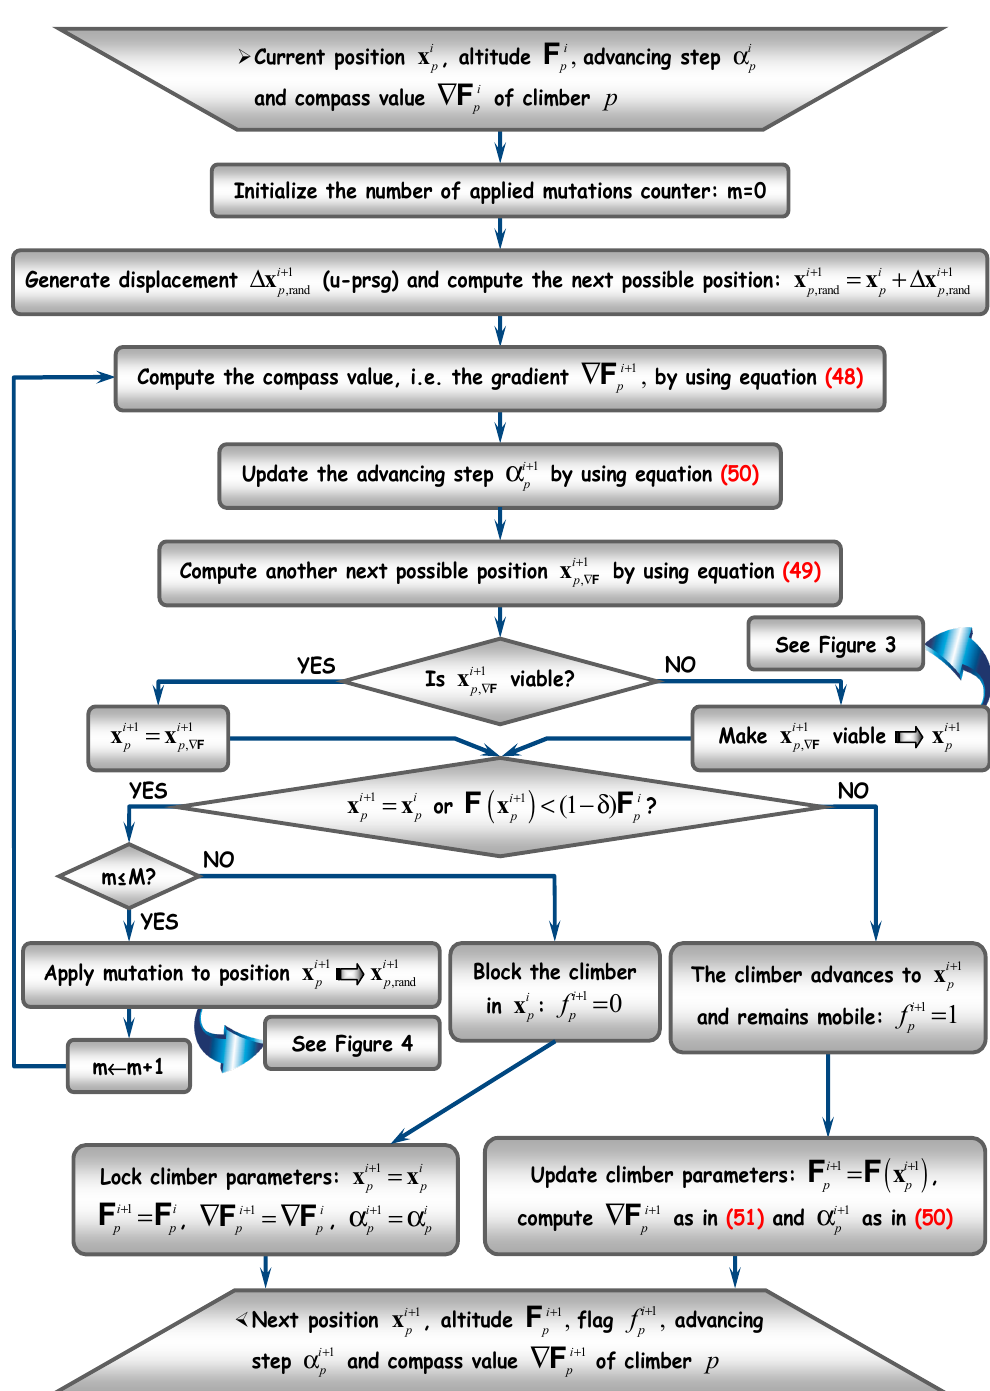
Figure 2. Upgrading procedure for climber parameters: position, altitude, flag, advancing step and compass.